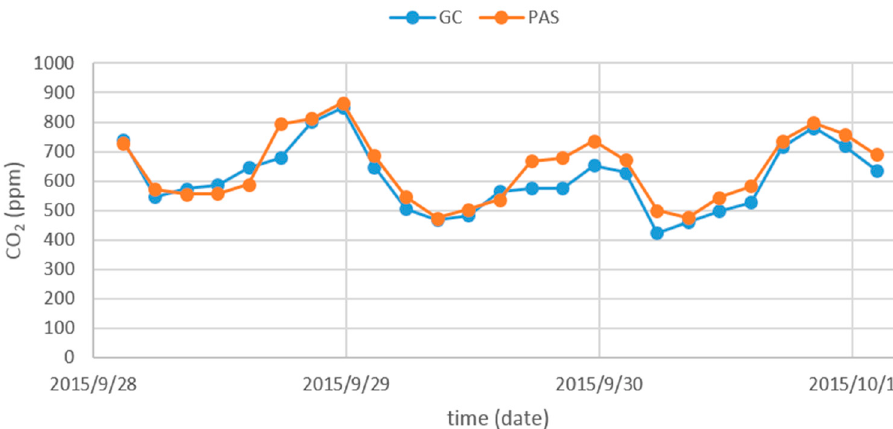
Figure 5. Absolute concentration of CO 2 measured by GC and PAS.